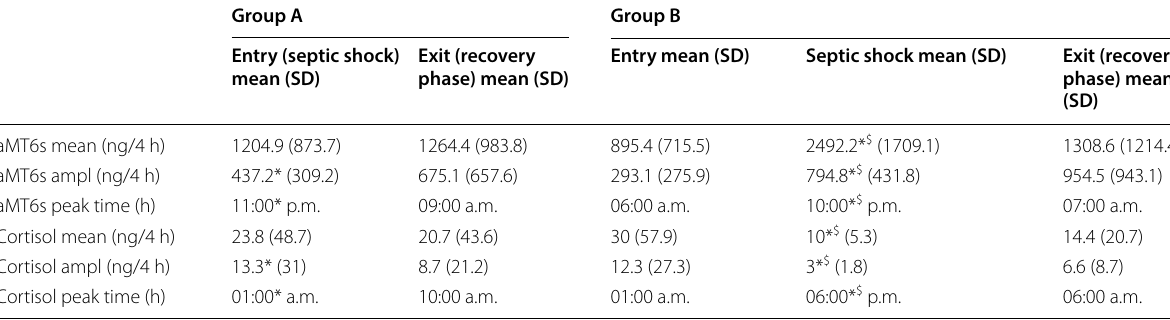
ampl amplitude (difference between peak and mean values) * Statistically significant ( p < 0.05) for comparisons between septic shock and exit $